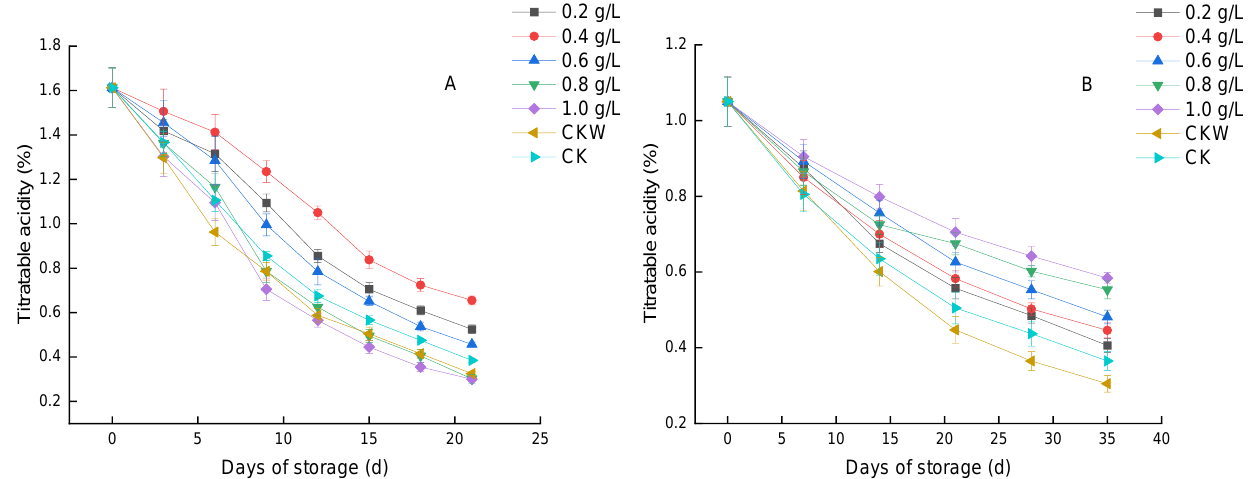
Figure 10. Effects of different Lycium barbarum leaf extract concentrations on the total acid content of cherry tomatoes at 20 ◦ C ( A ) and 5 ◦ C ( B